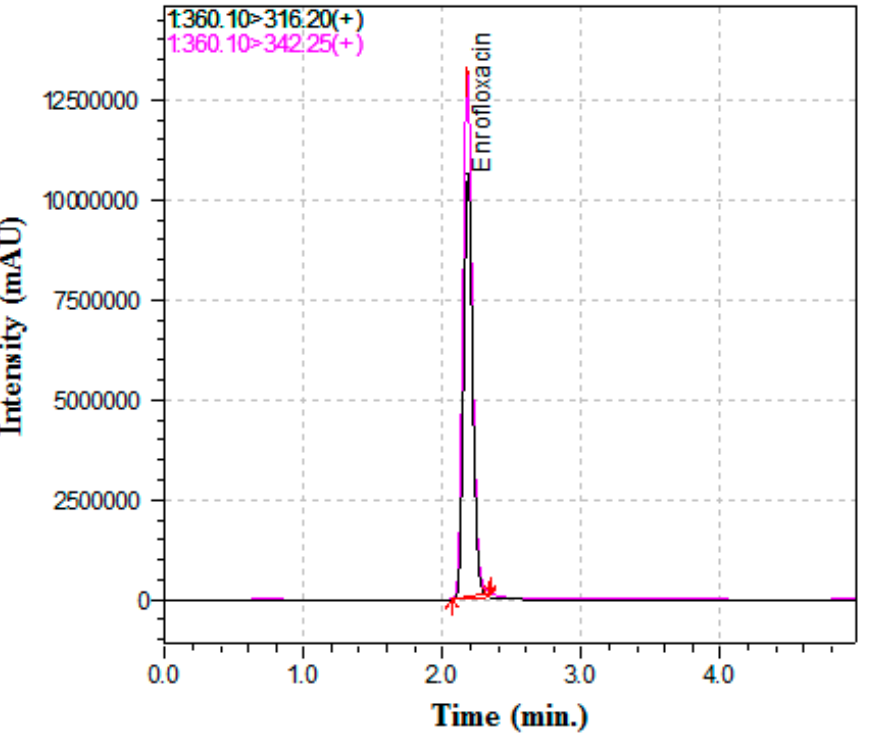
Figure 1. Representative chromatogram of enrofloxacin detected in NPJ. NPJ: veterinary nutritional product that was used in the poultry farm in Jeju Island, Korea, where enrofloxacin was detected in eggs.